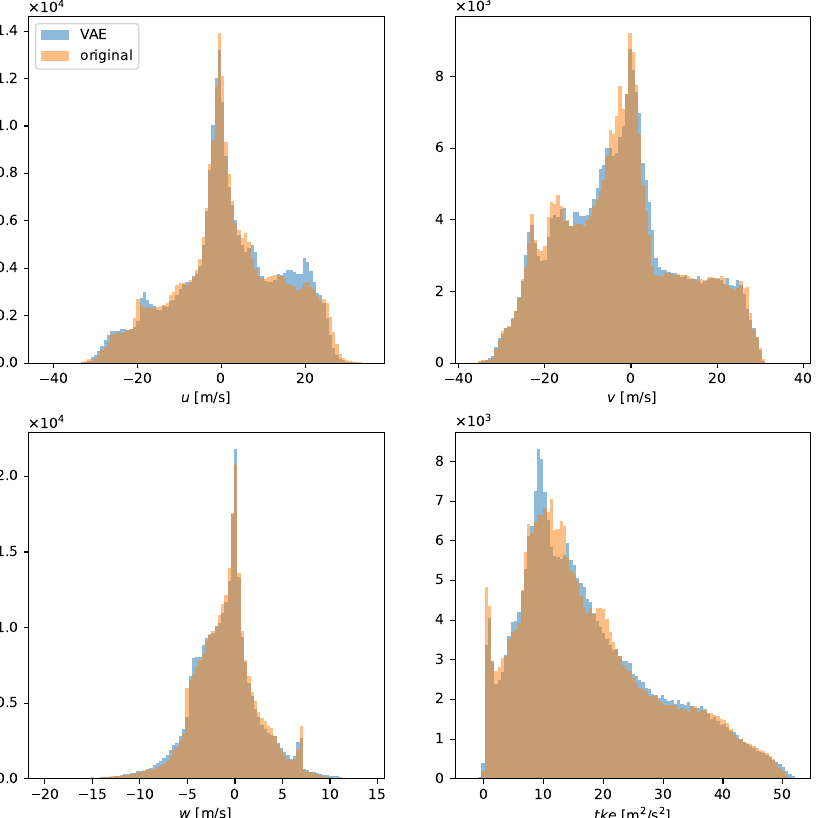
Figure 10. Histogram of the velocity components u , v , w , and TKE of cycle 3 from the original multicycle dataset and the VAE generated